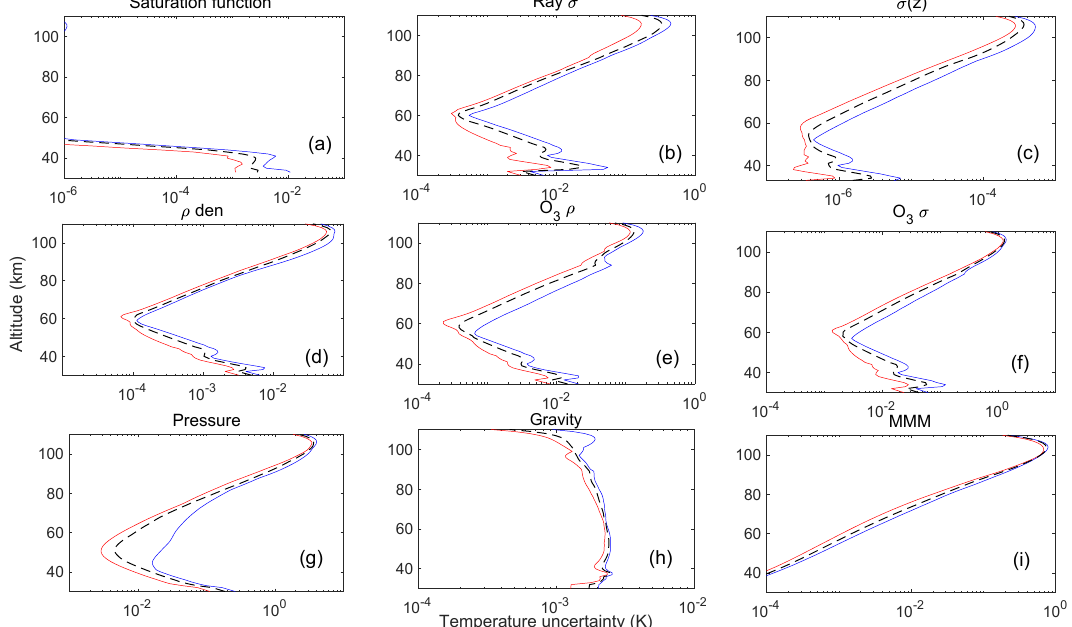
Figure 7. PCL temperature systematic uncertainty due to the (a) saturation function (1994 to 1998 only), (b) Rayleigh extinction cross section, (c) Rayleigh cross section variation with height, (d) air density affect on Rayleigh extinction, (e) ozone absorption cross section (f) ozone concentration, (g) seed (tie-on) pressure, (h) gravity model, and (i) mean molecular mass variation with height. In each figure, red, blue, and black lines are the minimum, maximum, and median between all months, respectively.